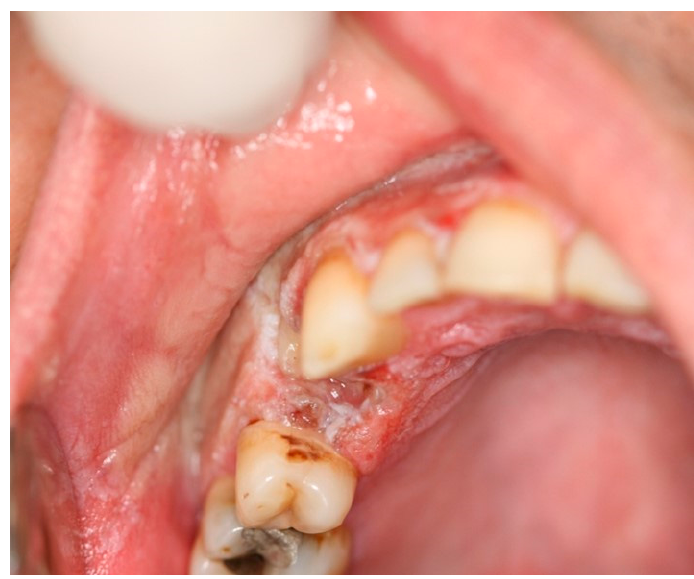
Figure 3. Superficial oral burn due to placement of an over-the-counter anaesthetic gel.